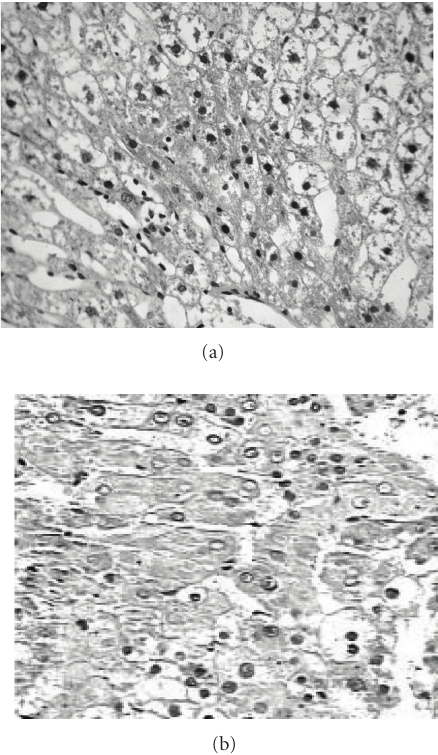
Figure 2: TCA-treated rats showing loss of normal architecture with oval- or irregular-shaped hepatocytes, denser nuclear chro- matin, the ratio of nucleus to cytoplasm was increased, many trans- formed liver cells were frequently binucleated and hyperchromatic (basophilic).